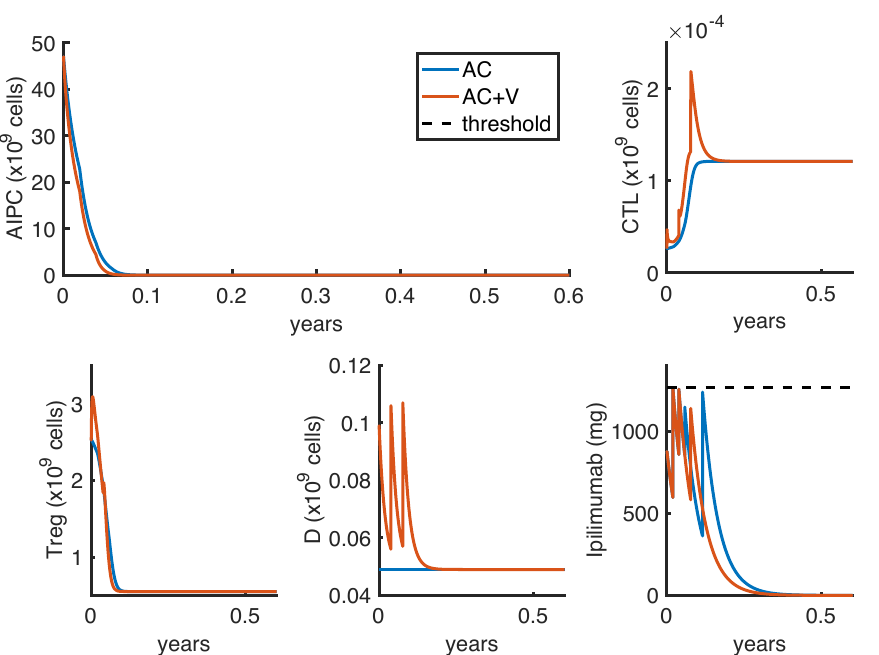
Figure 5. Administration protocol with the aim of tumor eradication as result of the optimization problem OP2, with ∆ t = 1 week. Blue lines represent the model dynamics in case of ipilimumab mono-therapy (AC), while orange lines represent the one in case of ipilimumab and sipuleucel-T combination therapy (AC+V). The ipilimumab threshold has been highlighted with a black dotted line.